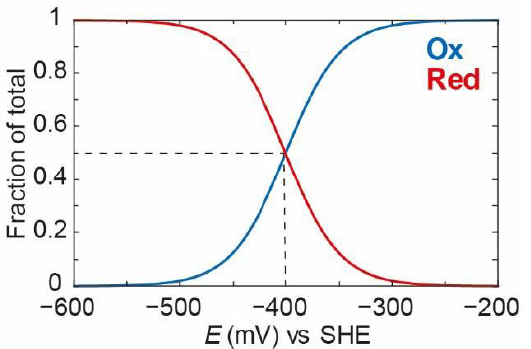
Figure 2. Variation of the fraction of oxidised ( Ox , blue) and reduced ( Red , red) species as a function of the applied potential ( E ) in mV. The curves were obtained using Equations (2) and (3) with n = 1 and E O = − 400 mV vs.